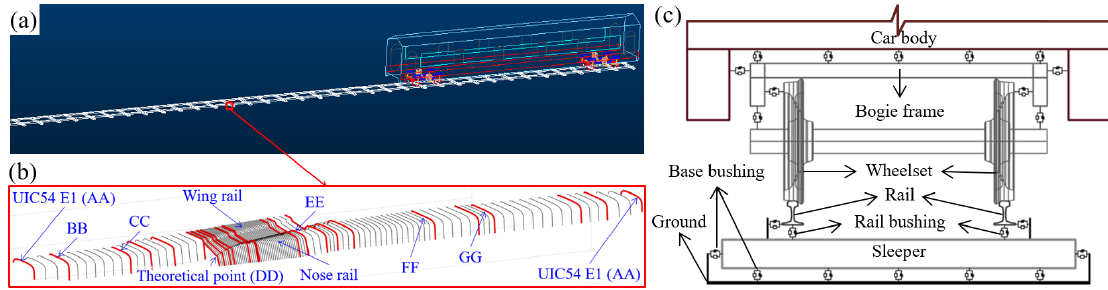
Figure 10. MBS model: ( a ) vehicle – track model, ( b ) flexible connections in the model, and ( c ) input crossing profiles (the control sections are marked in red).